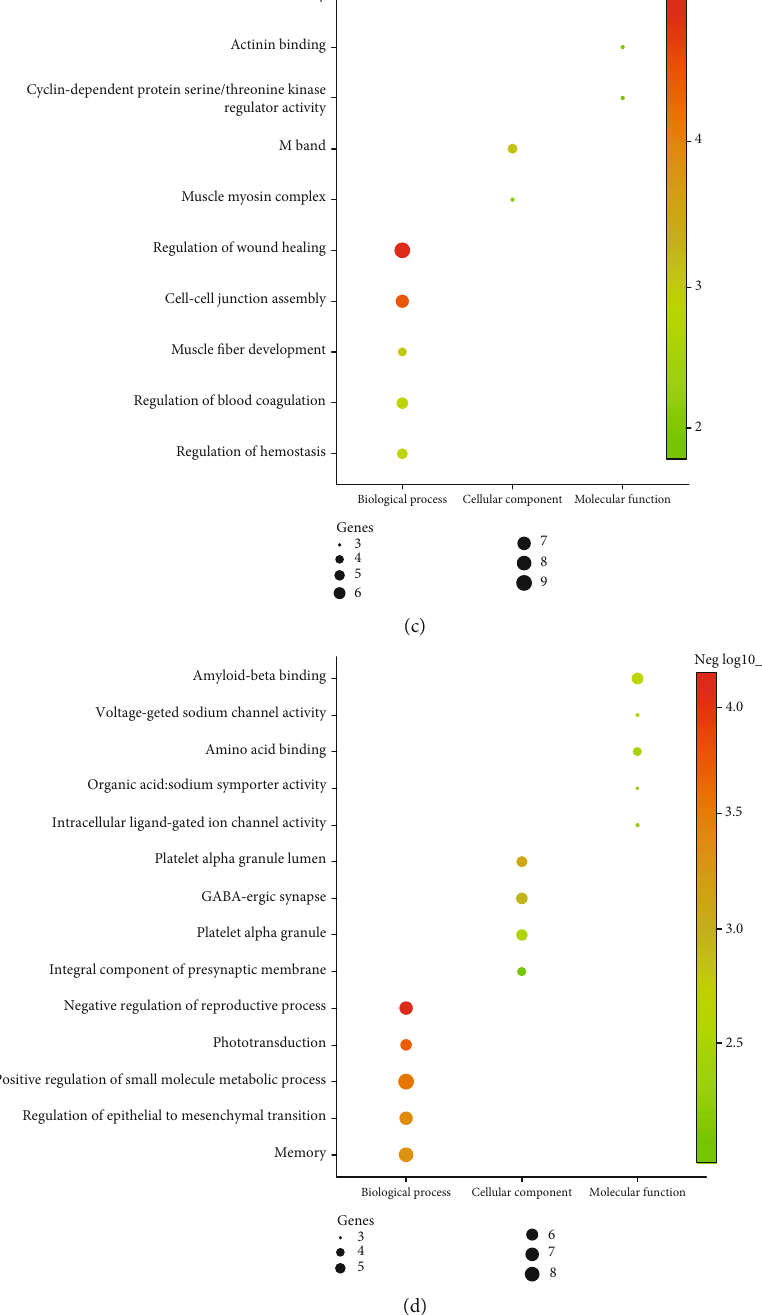
Figure 2: Top 5 GO enrichment analysis of DEGs. GO characteristics of the DEGs are described as biological process, molecular function, and cellular component. The setting conditions were as follows: P : adj : value < 0 : 05 , genecount ≥ 3 . (a) Upregulated genes between the RA and No-RA groups. (b) Downregulated genes between the RA and No-RA groups. (c) Upregulated genes between the M-RA and F-RA groups. (d) Downregulated genes between the M-RA and F-RA